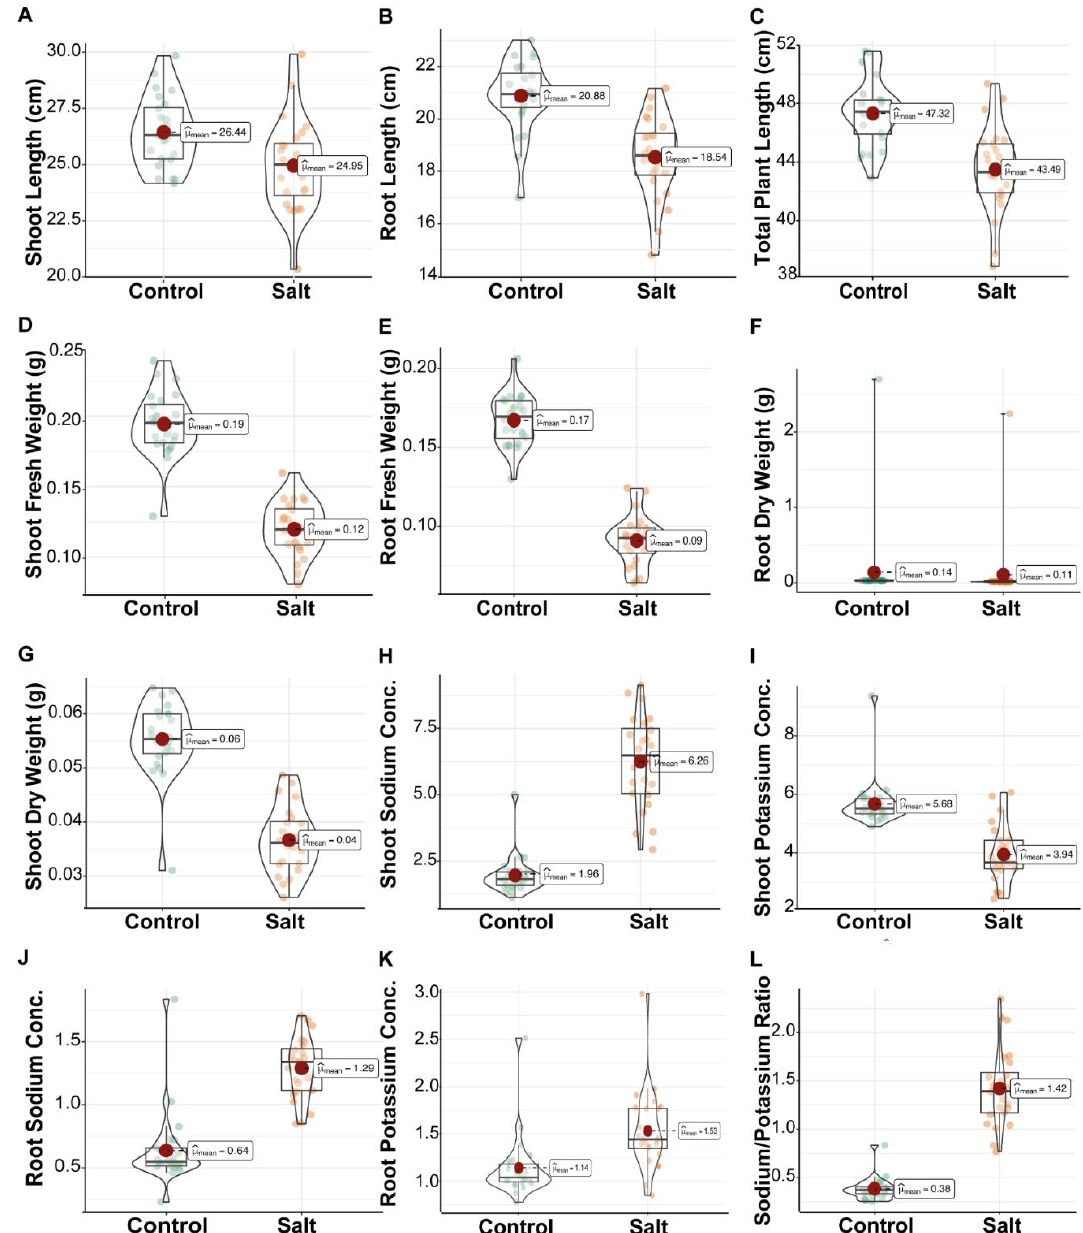
Figure 1. Comparison of 12 morpho-physiological traits ( A – L ) of rice genotypes at seedlings stage. GSR lines were evaluated in control and 200 mM salt stress (Salt) under glasshouse conditions. Circles with different colors represent the genotypes. Inside the violin plot, big red circle showed the mean, boxplot represent the median (middle line), minimum, maximum, and error bars.